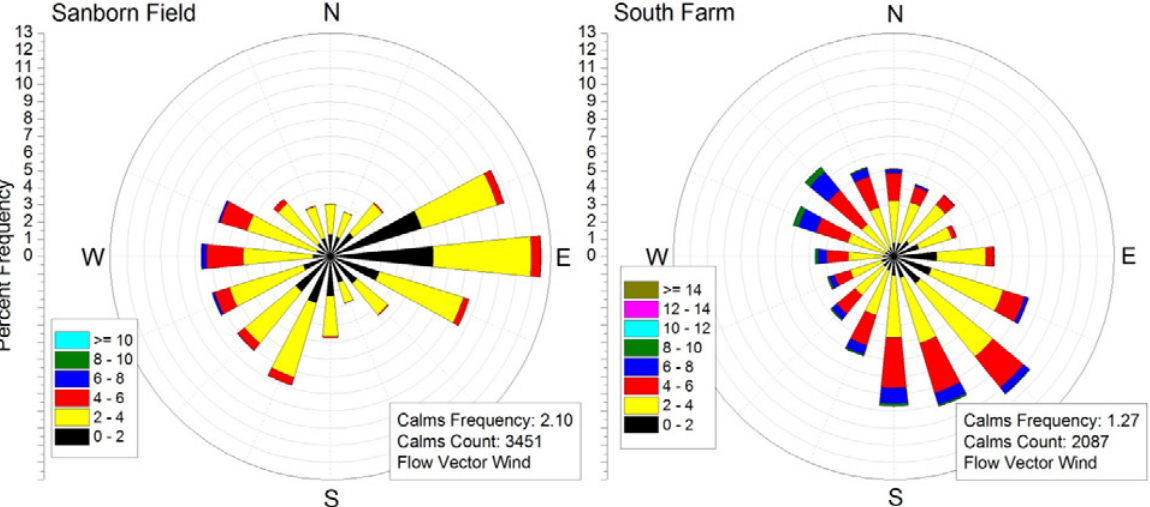
Figure 5. Wind directions at Sanborn and South Farm monitoring sites